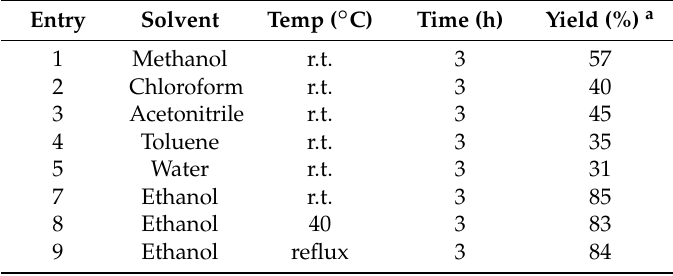
Table 1. Optimizing the reaction solvent for the synthesis of 4a .